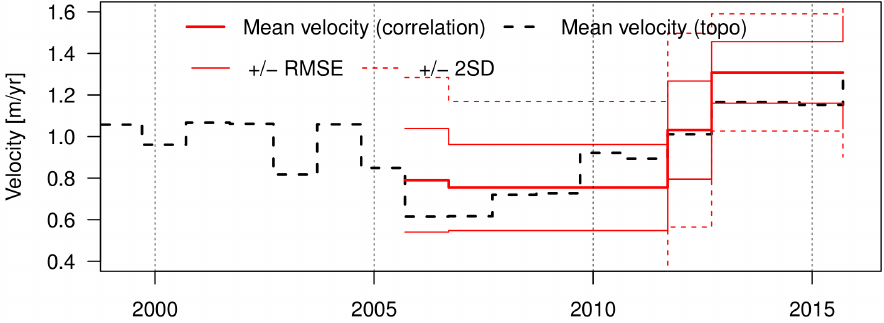
Figure 5. Evolution of the Laurichard rock glacier mean velocity since the early 2000s, derived from ground topographic measurements (total station and DGPS; bold black dashed line) and from image (DEM) correlation (red